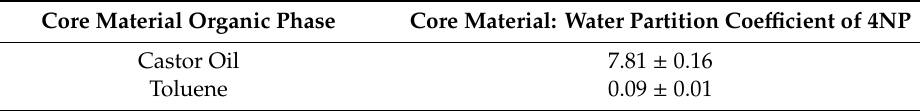
Table 5. Core material:water partition coe ffi cients for 4-nitrophenol (4NP).